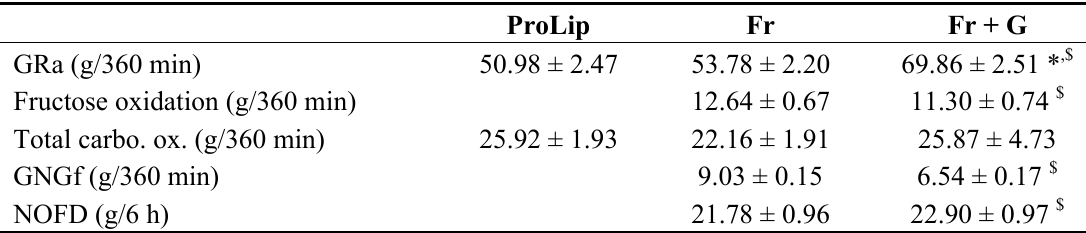
Table 3. Total glucose rate of appearance (GRa, n = 8), fructose oxidation, total net carbohydrate oxidation (total carbo. ox., n = 6), gluconeogenesis from fructose (GNGf, n = 8) and non-oxidative fructose disposal (NOFD, n = 6) cumulated over six hours after the ingestion of test meals. * p < 0.05 vs . ProLip, $ p < 0.05 vs . Fr.